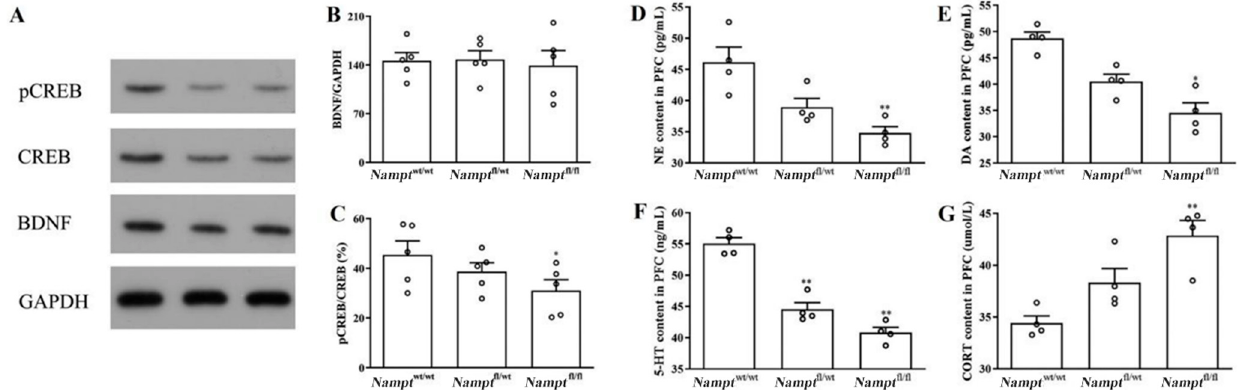
Figure 5. BDNF, CREB, NE, DA, 5-HT, and CORT levels in the PFCs of Nampt flox/flox mice. (A)